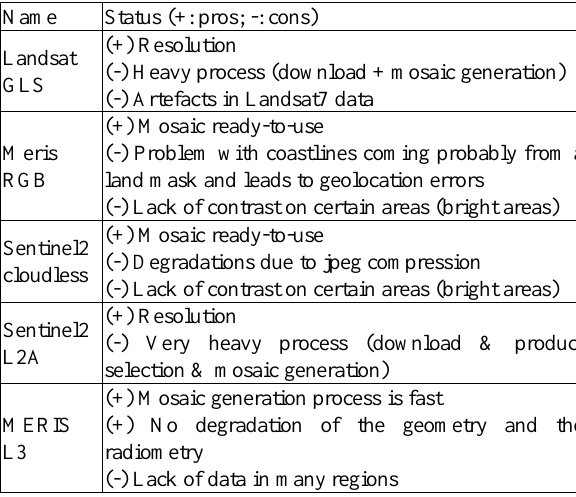
Table 3. Pros & cons of the investigated global datasets described in Table